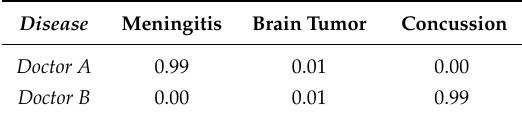
Table 1. Physicians’ beliefs about a patient’s disease (according to [65]).